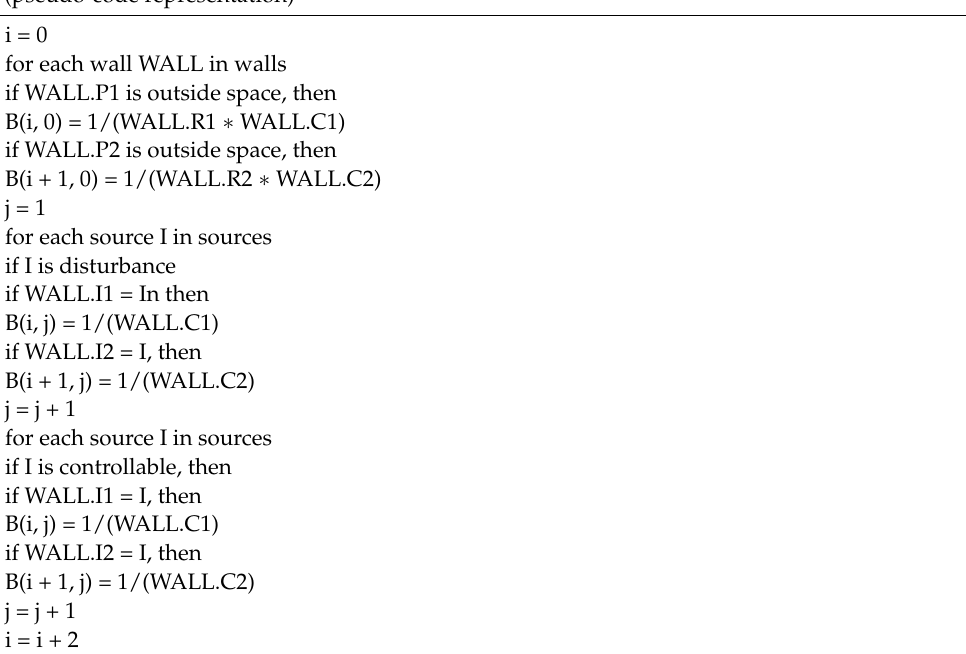
Algorithm 4. The definition of the structure of the input matrix B —walls, spaces and sources (pseudo-code